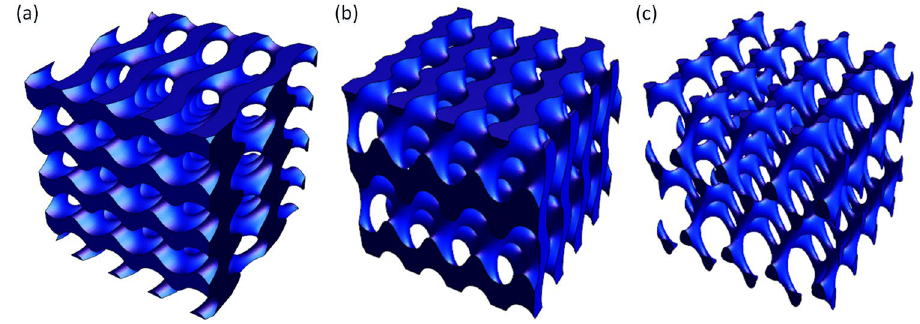
Figure 7. Bionic porous scaffold model structure, ( a ) TGa scaffold, ( b )TGb scaffold, ( c )TGc scaffold.